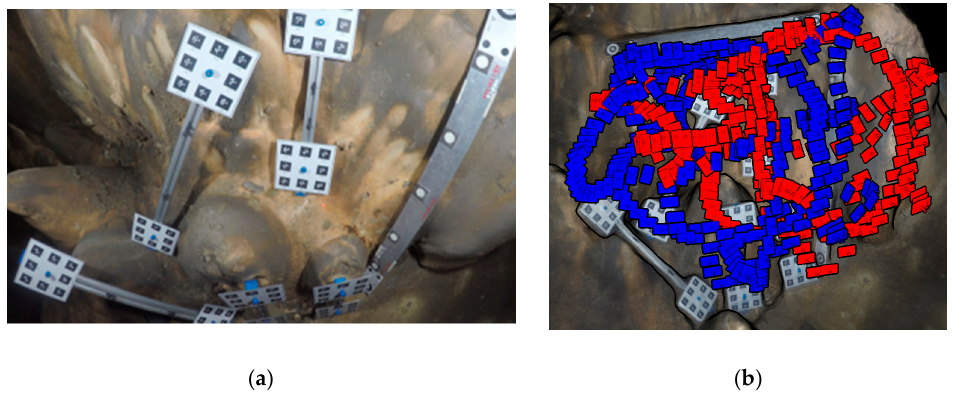
Figure 17. The calibration area (testfield) set up in Grotta Giusti ( a ); camera network with in red and blue the camera right and left positions, respectively ( b ).